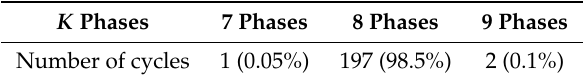
Table 3. The gait phase classification results of 200 gait